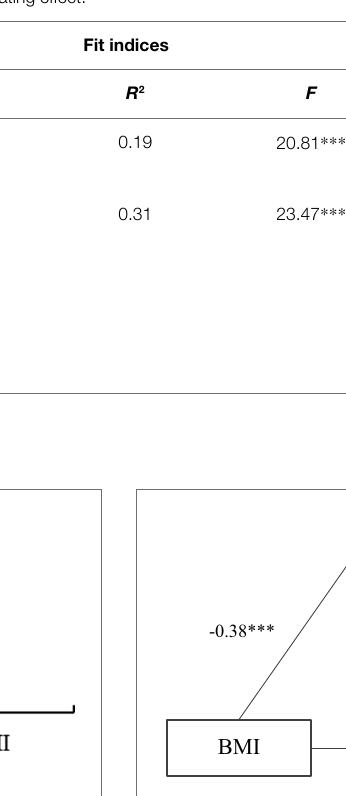
TABLE 6 | The moderating effect of the family support on the mediating